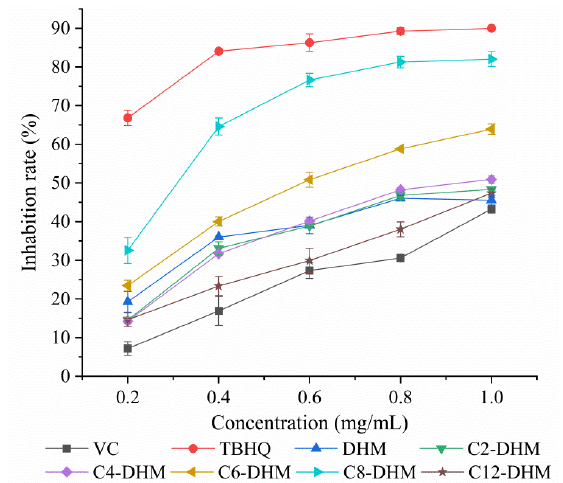
Figure 7. Inhibition ability of DHM and its derivatives on lipid peroxidation.